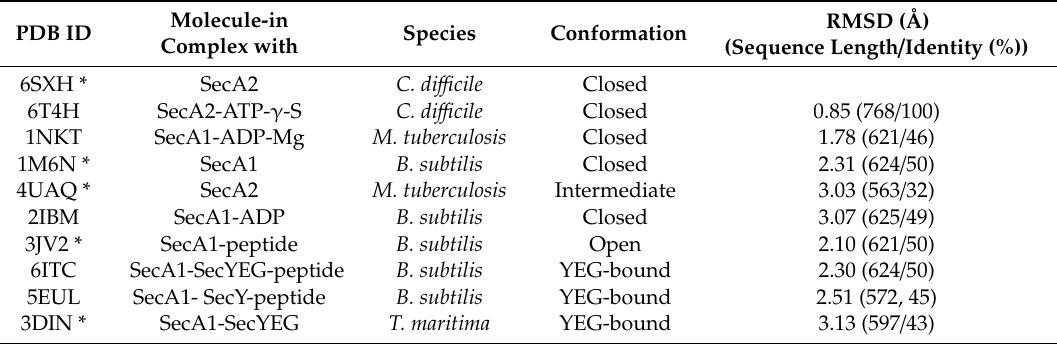
Table 2. Superposition of CDSecA2 and other SecA molecules. All structures were superimposed onto the CDSecA2 molecule with flexible structure alignment by chaining aligned fragment pairs allowing twists using software FATCAT [25]. PPXD and C-terminal tails were excluded from the alignment. * marks the structure shown in Figure 1B or Figure